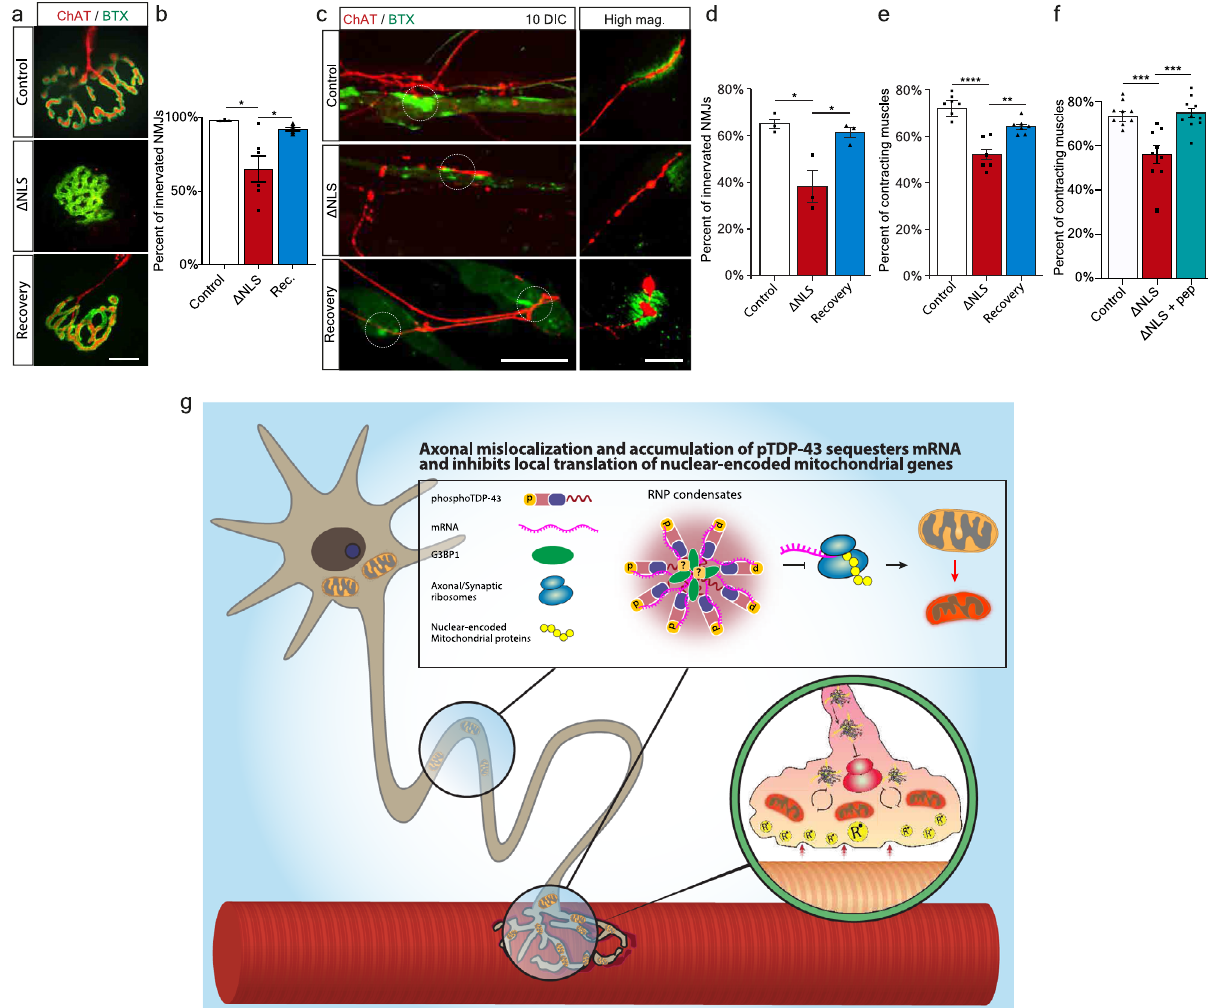
Fig. 8 Restoring TDP-43 Localization or Dissociation of TDP-43 Condensates Enables NMJ Functional Re-innervation. a Images and b Quanti fi cation of NMJs from control, TDP Δ NLS, and recovered-TDP Δ NLS mice. Quanti fi cation is of the percentage of innervated (Chat-BTX positive) NMJs in control, TDP Δ NLS and recovered-TDP Δ NLS mice. Scale bar = 10 µ m. n = 3,3,3 mice. Data are presented as mean values ± SEM. One-way ANOVA with Holm-Sidak correction * p = 0.291 (left), * p = 0.291 (right). c Images and d quanti fi cation of NMJ innervation in vitro, assessed by co-expression of pre- and post- synaptic elements (percent of ChAT-BTX clusters) in control, TDP Δ NLS and recovered-TDP Δ NLS co-cultures. Scale bar = 40 µ m in main image, 5 µ m